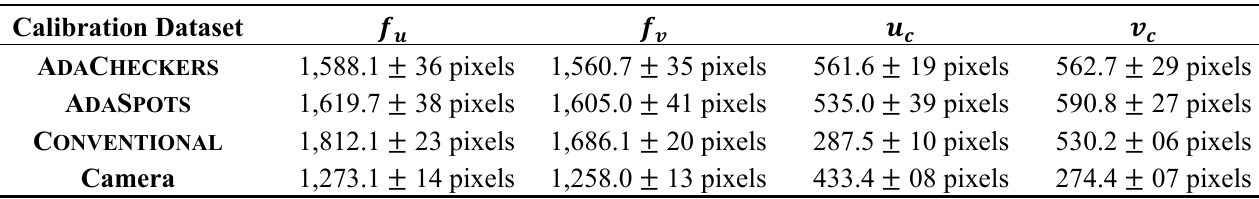
Table 2. Calibrated linear intrinsic parameters with standard errors.